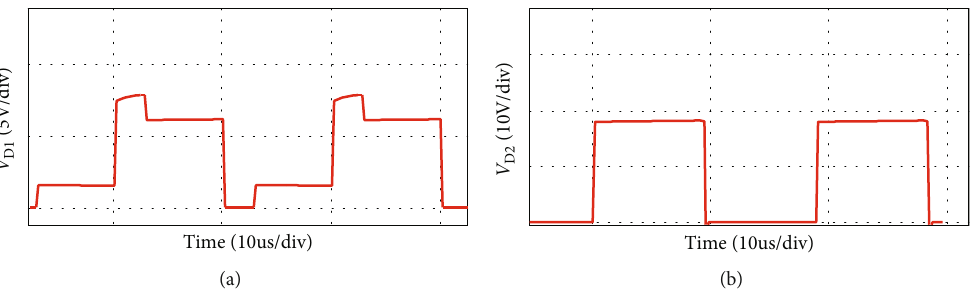
Figure 13: Diode D